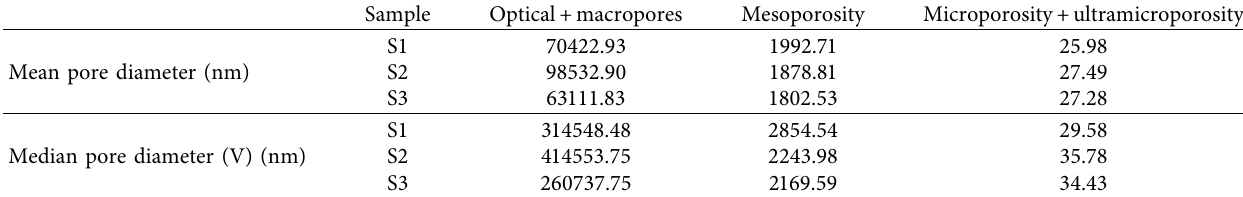
Table 6: Mean and median pore throat diameters from the MIP test.